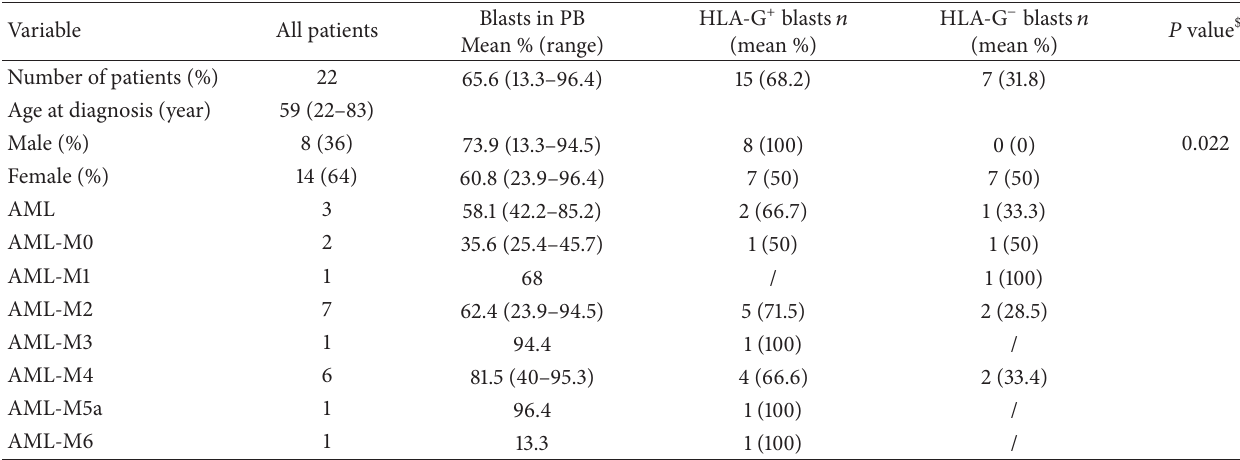
Table 1: Clinical patients’